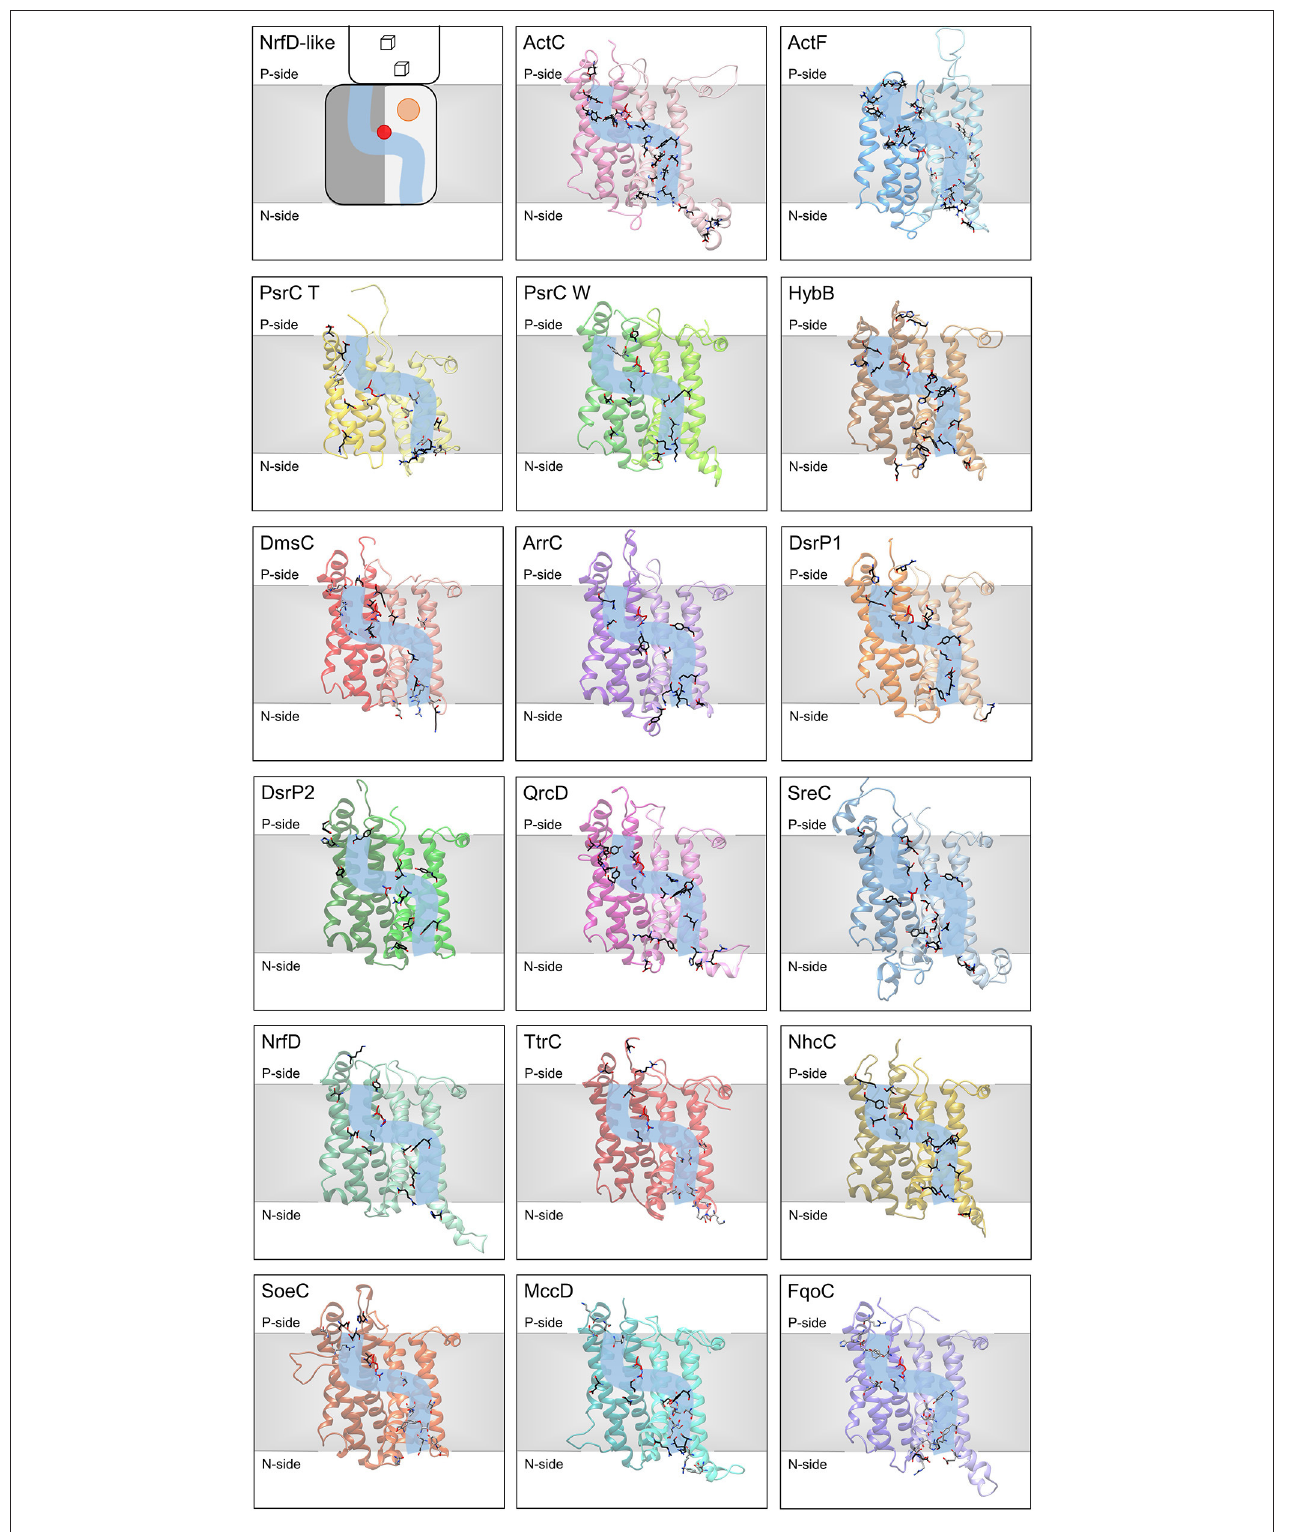
FIGURE 7 | Ion-translocation pathway. Structural models of NrfD-like subunits with amino acid residues putatively involved in ion-translocation. The top left side panel contains a general schematic representation of NrfD-like subunits. Each protein is composed by eight common TMH that form two four-helix bundle (TMHs 1–4,